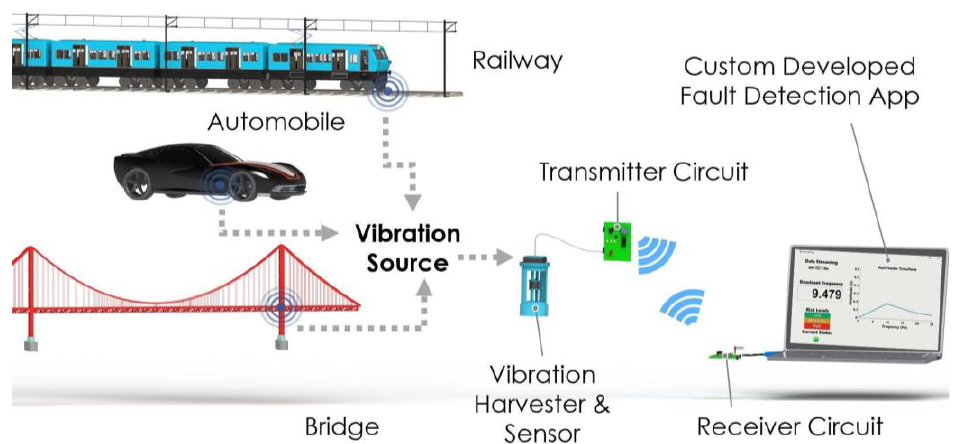
Figure 1. Design and concept of the wireless self-powered, self-contained, and eco-friendly vibration sensor system and its main components.